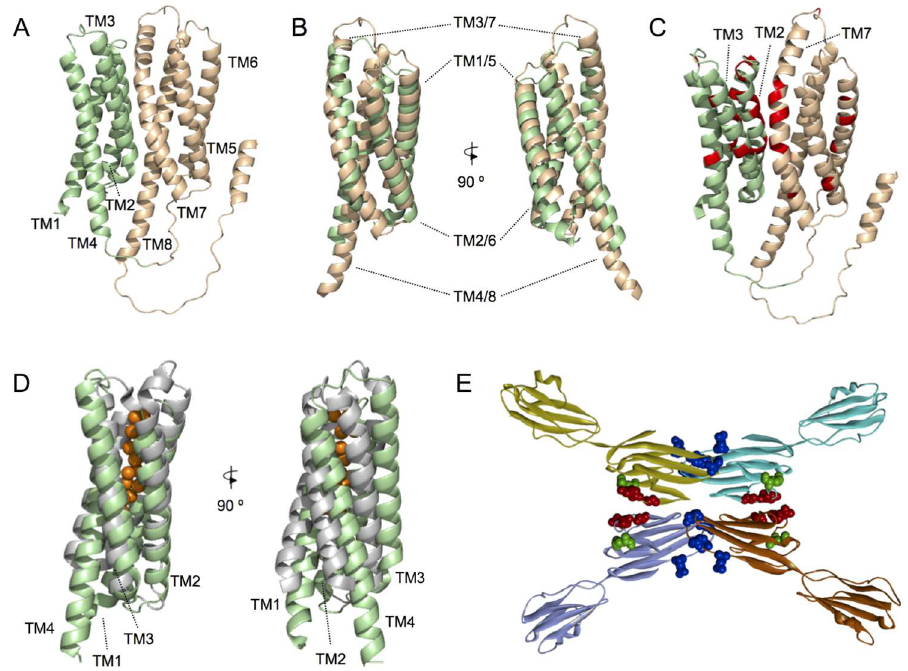
Figure 1. Structural models of MLC1 and GlialCAM proteins. ( A ) Alphafold structural model of monomeric MLC1. Helices 1 to 4 and 5 to 8 are coloured pale green and wheat, respectively. ( B ) Structural superimposition of the two MLC1 subdomains, comprised of TMs 1 to 4 (pale green) and 5 to 8 (wheat), respectively. Two different views, rotated by 90°, are shown. ( C ) MLC causing mutations (red) depicted in the MLC1 structural model. Preferential localization of mutated residues is located in the interaction surface defined by the two MLC1 subdomains (TMs 1 to 4 (pale green) and 5 to 8 (wheat)). ( D ) Structural superimposition of MLC1 structural model TM1 to 4 (pale green) and a prokaryotic soluble copper storage protein from Streptomyces lividans (light grey) (PDB ID 6Q6B). Two different views, rotated by 90 ◦ , are shown. ( E ) Summary of the structural model proposed for GlialCAM homodimers forming cis and trans interaction through different surfaces of its IgV domain. Cis dimerization is achieved by interactions between two opposing beta-strands of the IgV domain and trans interactions occur between salient loops of both IgV domains. Residues mutated in MLC2A patients (recessive) are shown in green, Residues mutated in MLC2B patients are shown in red or blue (affecting blue the interactions in trans